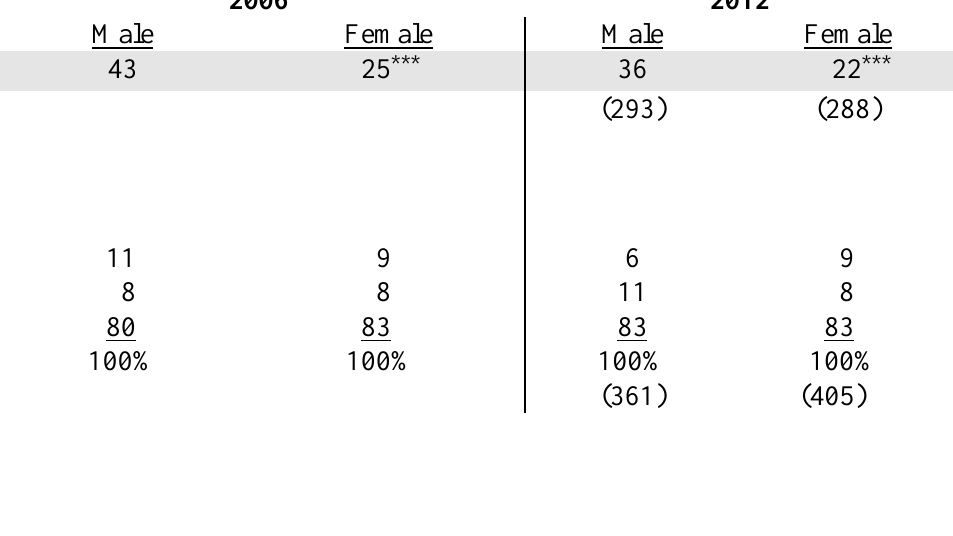
2006 2012 Male Female Male Female